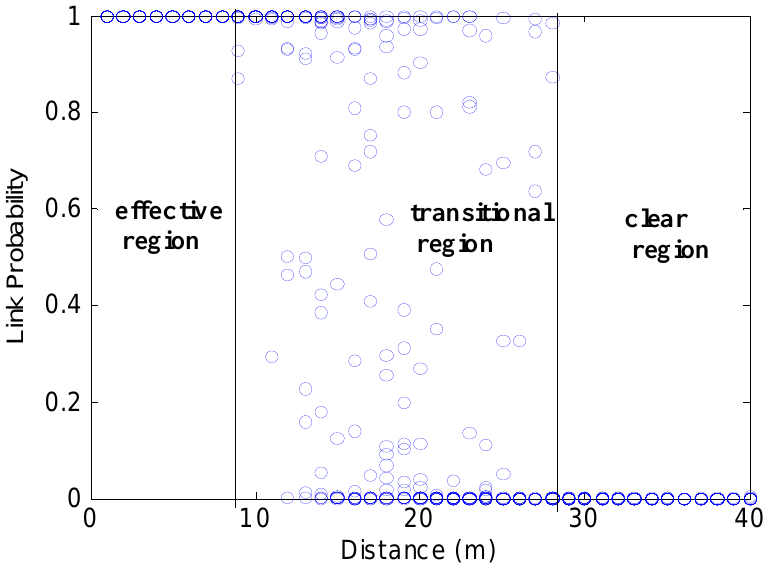
Figure 2. Analytical PRR to distance, obtained from (19) and (17), P f =50 Byte, h =2 Byte.